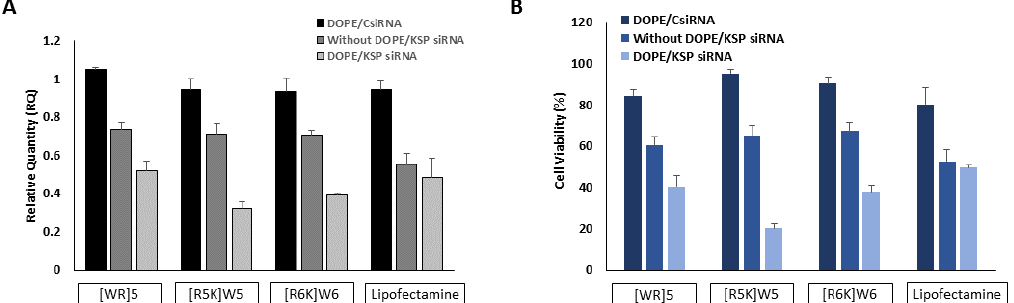
Figure 7. Silencing kinesin spindle protein (KSP) in MDA-MB-231 cells: ( A ) Silencing was evaluated at mRNA level using real-time PCR. Control siRNA (CsiRNA, only delivered with DOPE) or siRNA targeting selected protein (delivered with or without DOPE) were delivered using the designed peptides at N/P ratio of 20. All relative quantities were normalized based on mRNA levels of cells treated with normal saline (not shown). All relative quantities for targeted siRNAs were significantly different with CsiRNA group, and all mRNA levels for targeted siRNA groups were significantly different from corresponding ‘ without DOPE ’ levels ( p < 0.05). ( B ) Effect of silencing on MDA-MB- 231 cell viability was evaluated using CCK assay. Similar study groups were used, and results were normalized based on viability of the cells treated with normal saline (not shown). A similar trend in